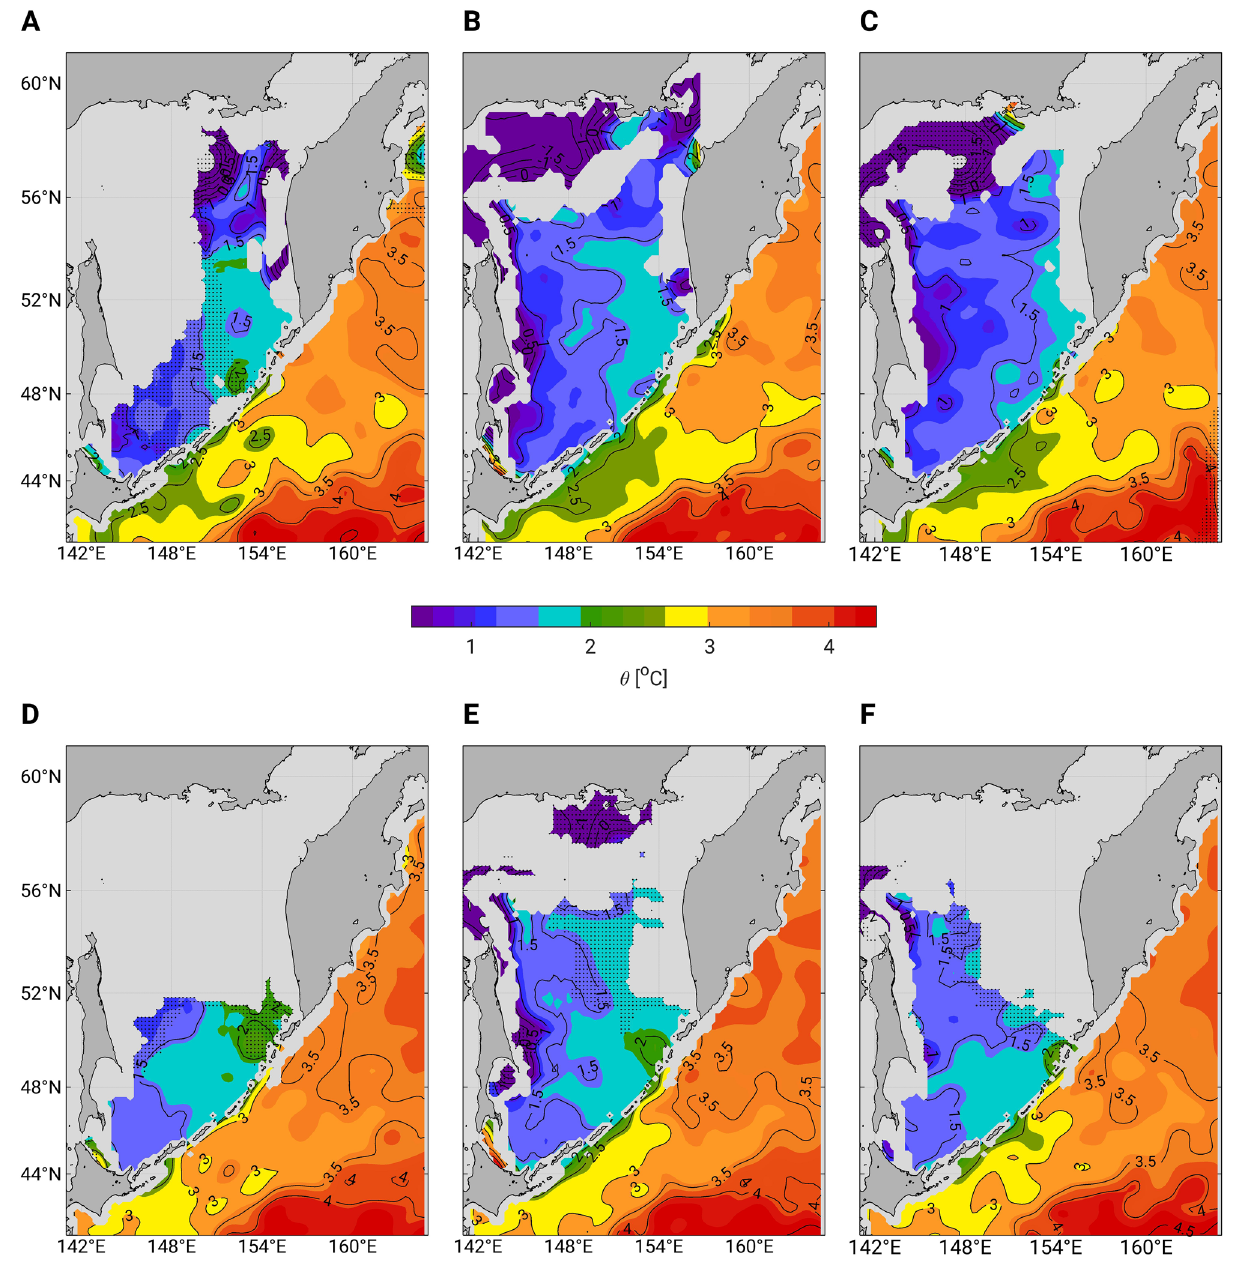
Figure 2. 4-Month climatologies of potential temperatures in the Sea of Okhotsk and the northern Pacific at 26.9